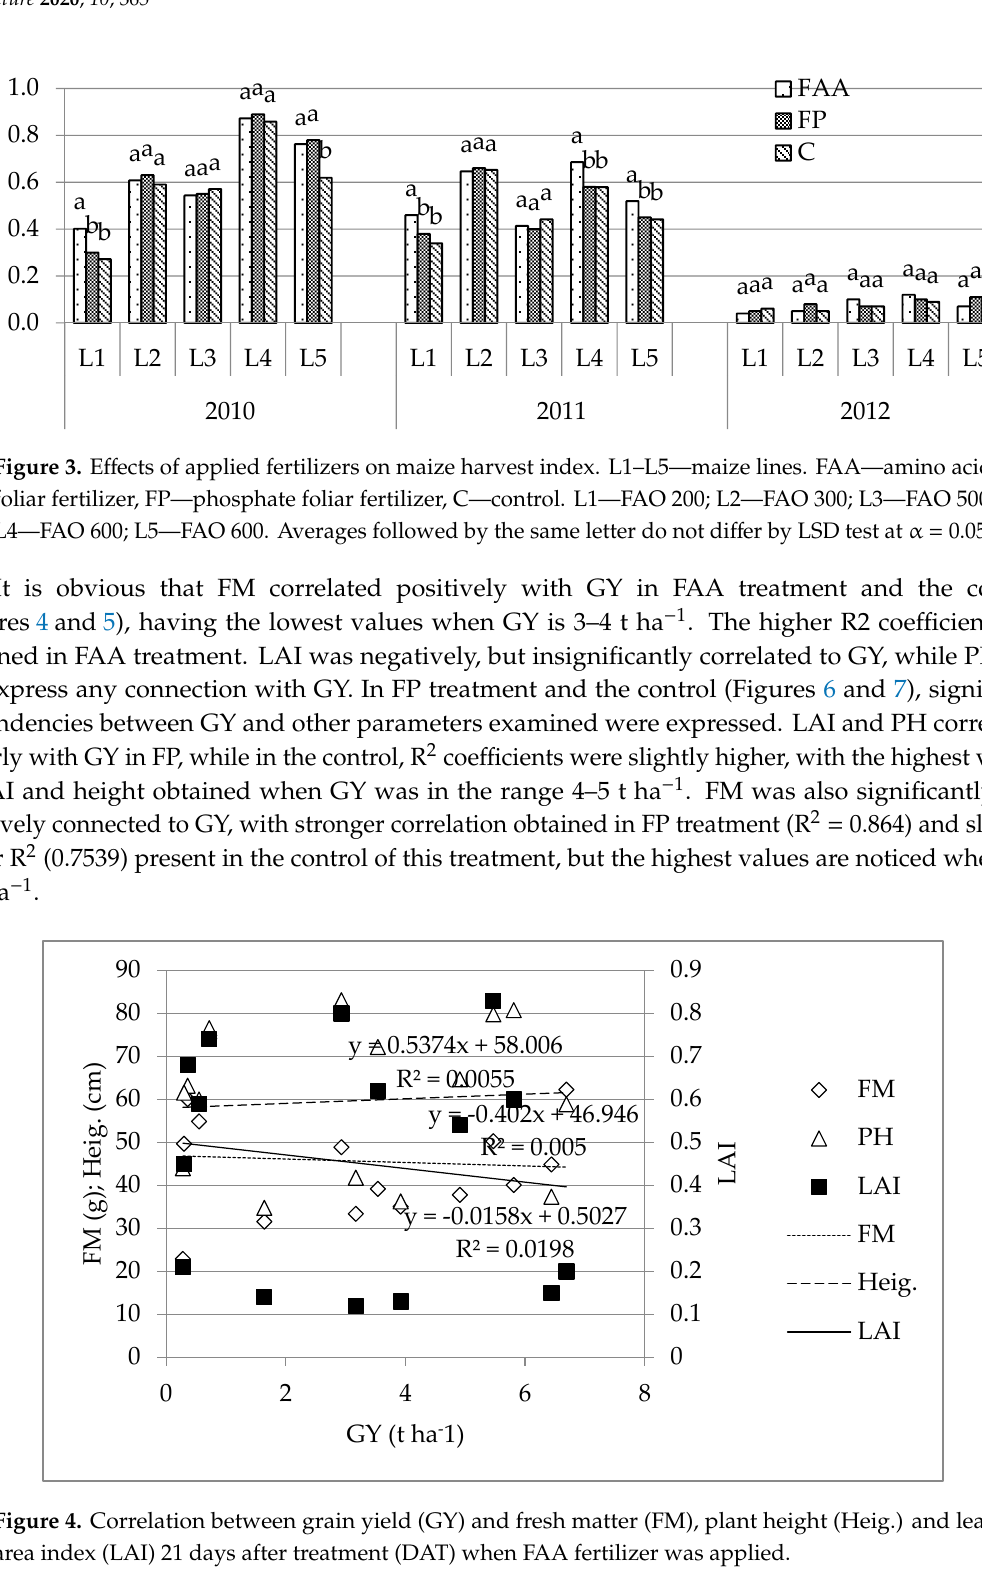
Figure 2. Effects of applied fertilizers on maize grain yield (t ha − 1 ). L1–L5—maize lines. FA—amino acid foliar fertilizer, FP—phosphate foliar fertilizer, C—control. L1—FAO 200; L2—FAO 300; L3— FAO 500; L4—FAO 600; L5—FAO 600. Averages followed by the same letter do not differ by LSD test at α = 0.05.